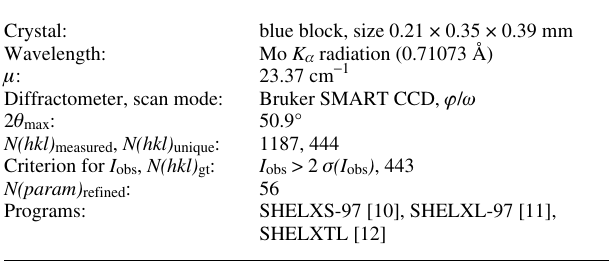
Table 1. Data collection and handling.